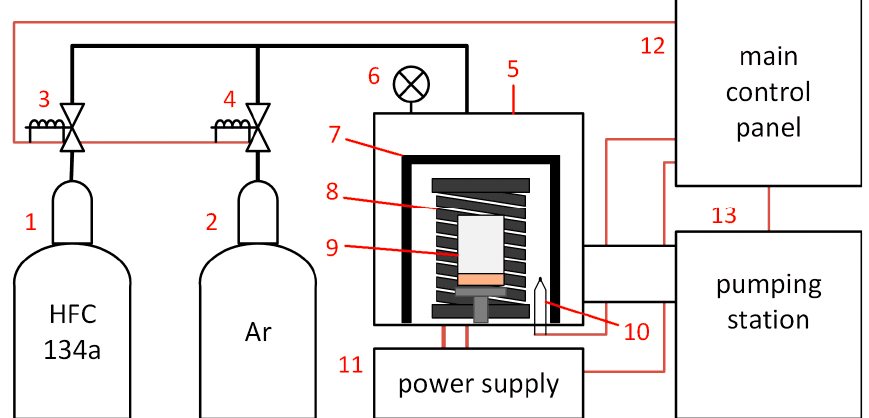
Figure 1. The schematic drawing of the home-made annealing furnace: 1—tetrafluoroethane gas cylinder; 2—argon gas cylinder; 3,4—electromagnetic valves; 5—vacuum furnace; 6—pressure gauge; 7—heat shield; 8—tubular graphite heater; 9—alundum crucible with powder sample; 10— thermocouple; 11—heater power supply; 12—main control panel (electromagnetic valves, pressure, power, and temperature controllers); 13—pumping station. Table 1. Samples notations and annealing conditions.